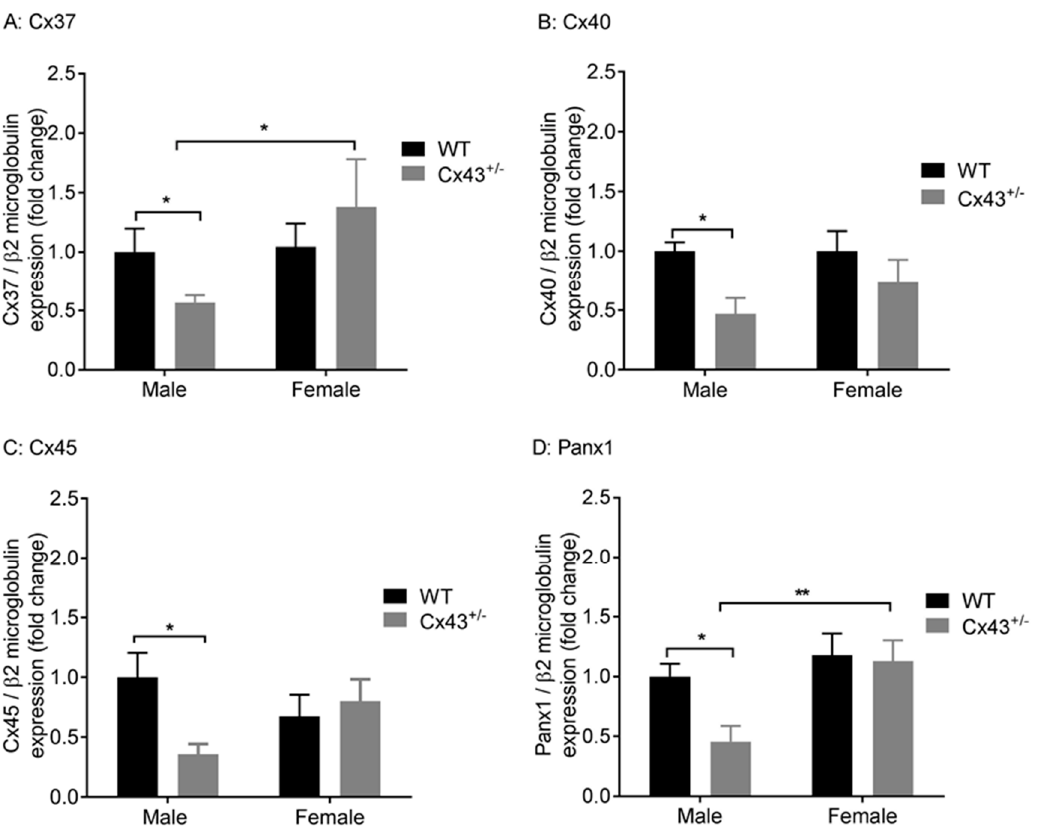
Figure 2. Gene expression of Cx37 ( A ), Cx40 ( B ), Cx45 ( C ), and Panx1 ( D ) in pulmonary arteries